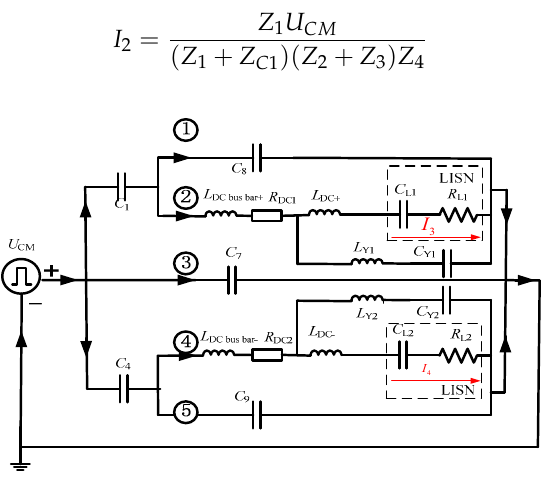
Figure 9. CM interference propagation path at 30 MHz.